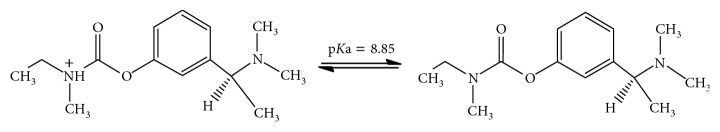
Ionisation of rivastigmine tartrate.